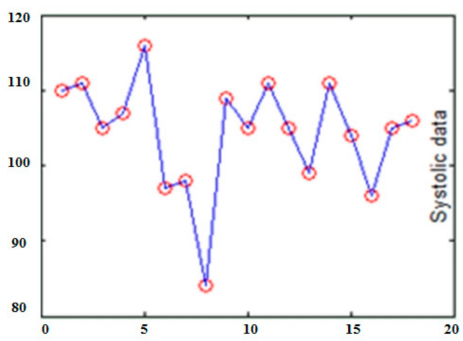
Figure 22. The learning of the neural network with the systolic data provided.